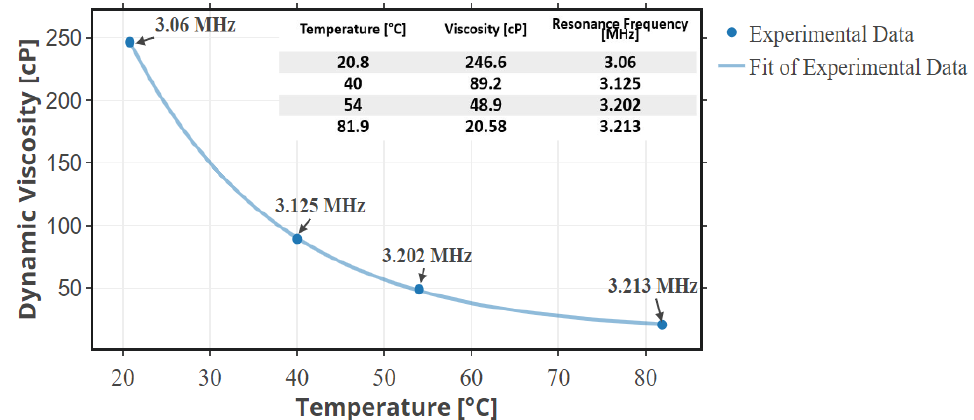
Figure 18. Resonance frequency comparison of an engine oil at varying temperatures.